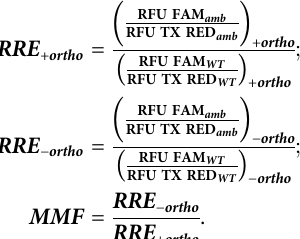
From the signal of the red and green channel, the RRE +ortho and RRE -ortho was determined and the MMF was calculated ( Figure 5A ) for each RFP-PNT-GFP amber mutant using the